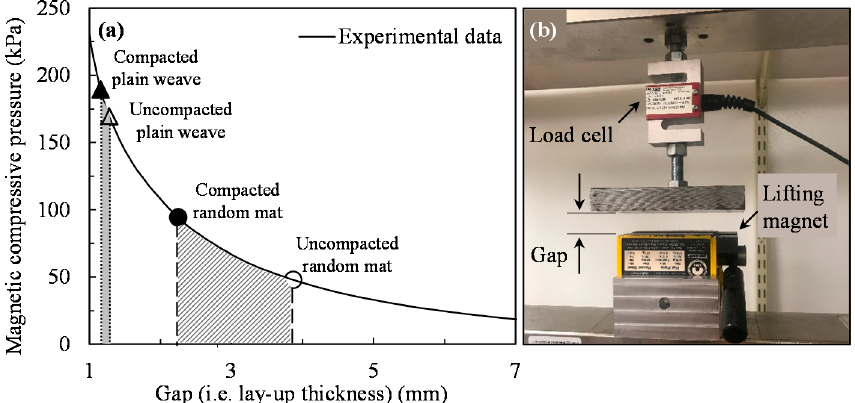
Figure 2. ( a ) Compaction pressure of the lifting magnet versus gap (i.e., lay-up thickness) and ( b ) a photograph of the experimental set-up used for measuring the magnetic pressure. The open and solid circles represent the thickness of uncompacted and compacted 4-ply random mat lay-up. The open and solid triangles correspond to the thickness of uncompacted and compacted 6-ply plain weave lay-up.